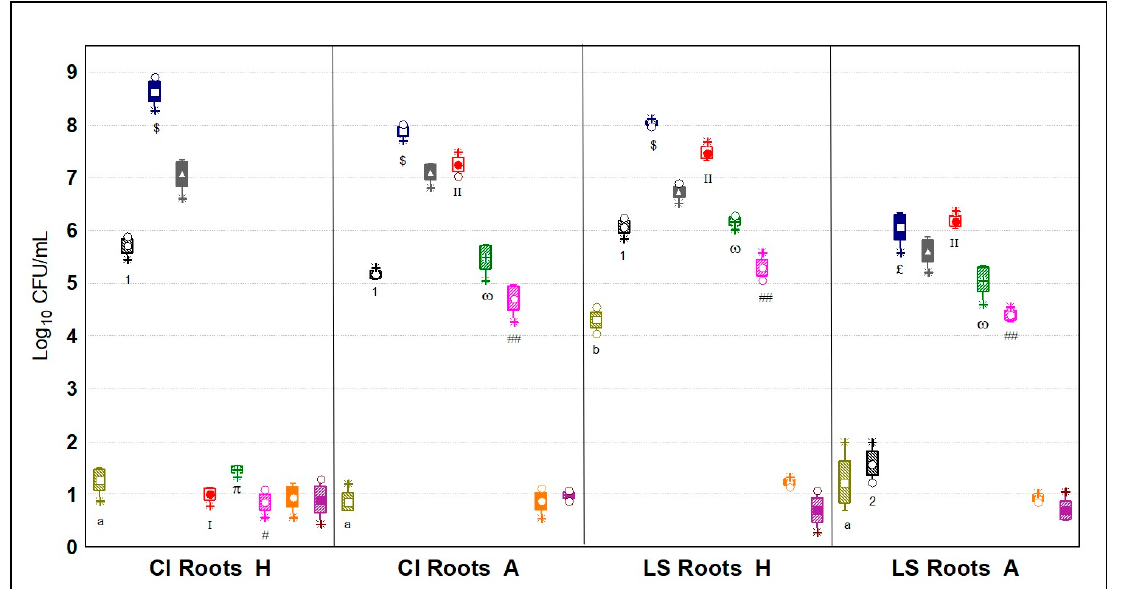
Figure 6. Microbial quantities in Log 10 CFU/mL ( n = 4) of nine different microbial targets; olive green = coliforms; black stripes = Enterobacteriaceae ; blue = aerobic mesophilic bacteria; gray = anaerobic mesophilic bacteria; red = psychrotrophic bacteria; green = lactic acid bacteria; fuchsia = yeasts and molds; orange = Pseudomonas spp . ; violet = enterococci; CI = Chicorium intybus ; H = hydroponic cultivation; A = aquaponic cultivation; LS = Lactuca sativa . Different letters, numbers, Greek letters, Latin numbers or symbols indicate statistical significance among a microbial target by Tukey’s HSD test ( p < 0.05). Samples were analyzed in duplicate from two independent experiments ( n = 4). Box = mean; rectangles = mean*S.D.; whiskers = min and max values; asterisks = extremes; dots =